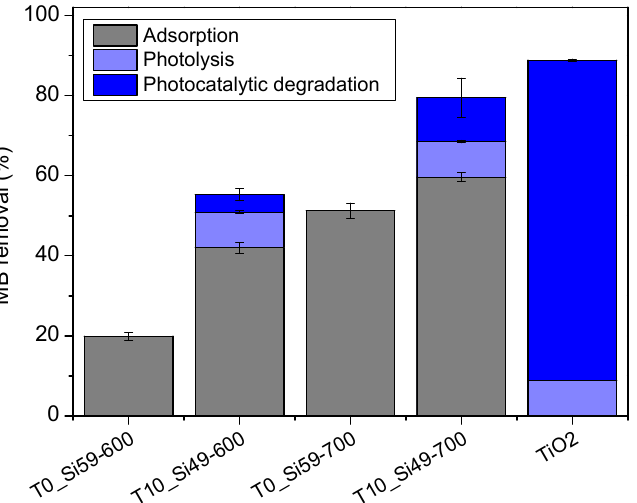
Figure 7. MB removal capacity of samples T0_Si59-600, T10_Si49-600, T0_Si59-700 and T10_Si49-700 after 24 h in the dark (adsorption), and under a UV light source (photocatalytic degradation) for the TiO 2 -incorporated samples (T10_Si49-600 and T10_Si49-700), for the equivalent amount of pure TiO 2 nanoparticles, and in the absence of any material (photolysis).